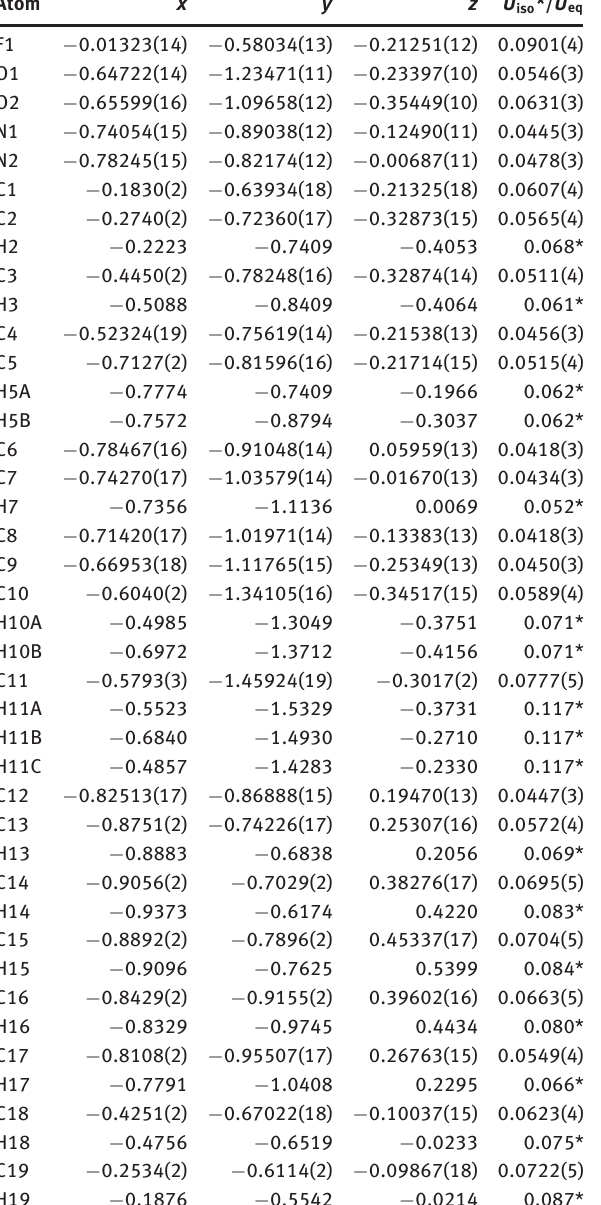
Table 2: Fractional atomic coordinates and isotropic or equivalent isotropic displacement parameters (Å 2 ).